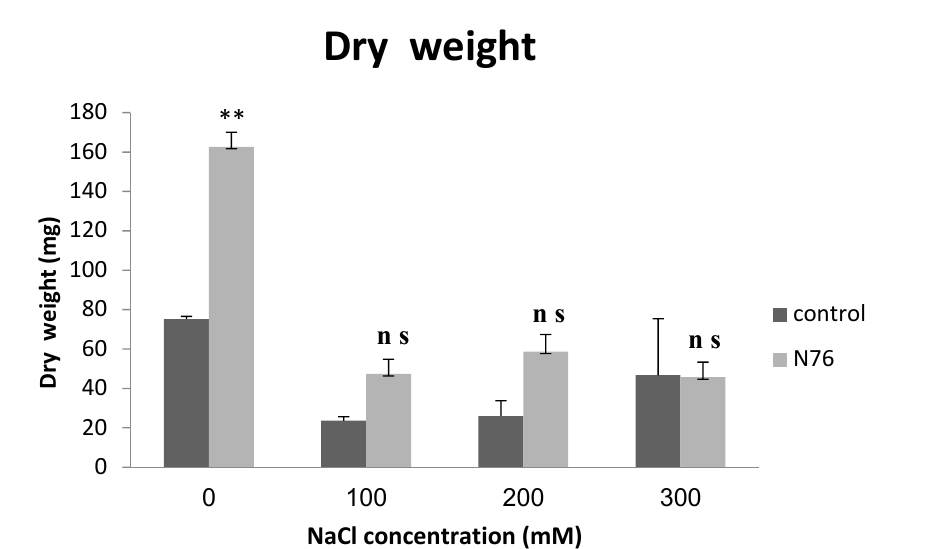
Figure 4. Effect of P. azotoformans on the dry weight of wheat seedlings under different NaCl concentrations. ns: no significant difference; **: significant difference ( p < 0.005).